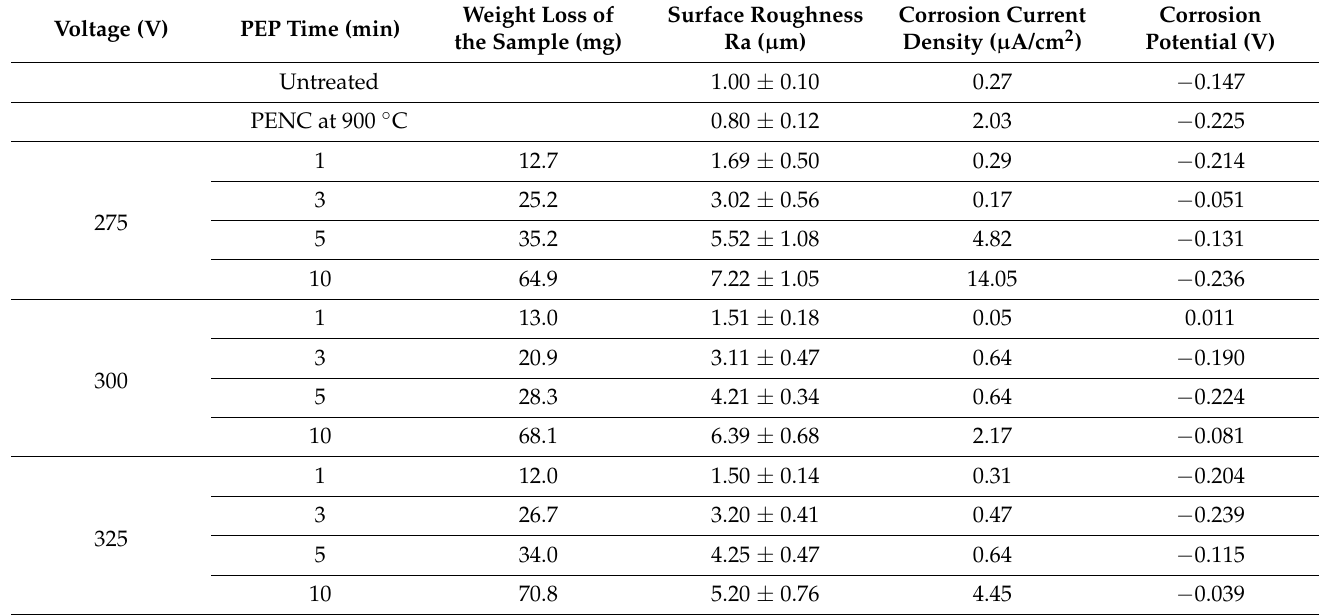
Table 3. Values of weight loss, surface roughness, corrosion current density and corrosion potential of CP-Ti samples after anodic PENC at 900 ◦ C and subsequent PEP in a solution of ammonium chloride (1%).